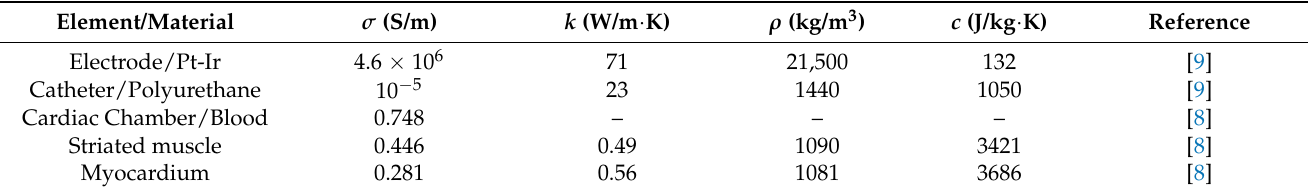
Table 1. Physical characteristics of tissues and materials of each element used in the